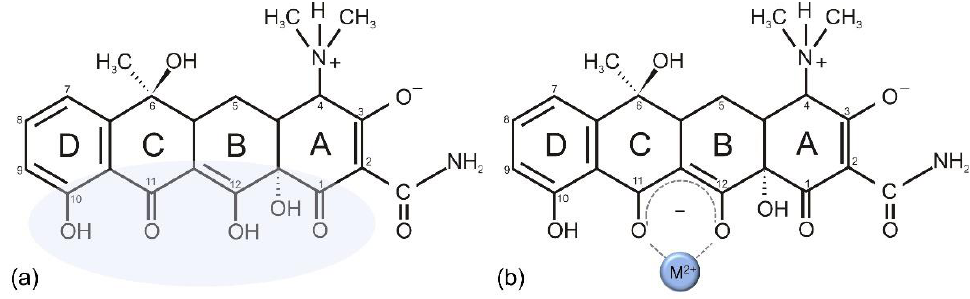
Figure 3. ( a ) Structure of tetracycline. The shaded area emphasizes the part relevant for chelating ability. ( b ) An example of a simple tetracycline–Mg chelate.